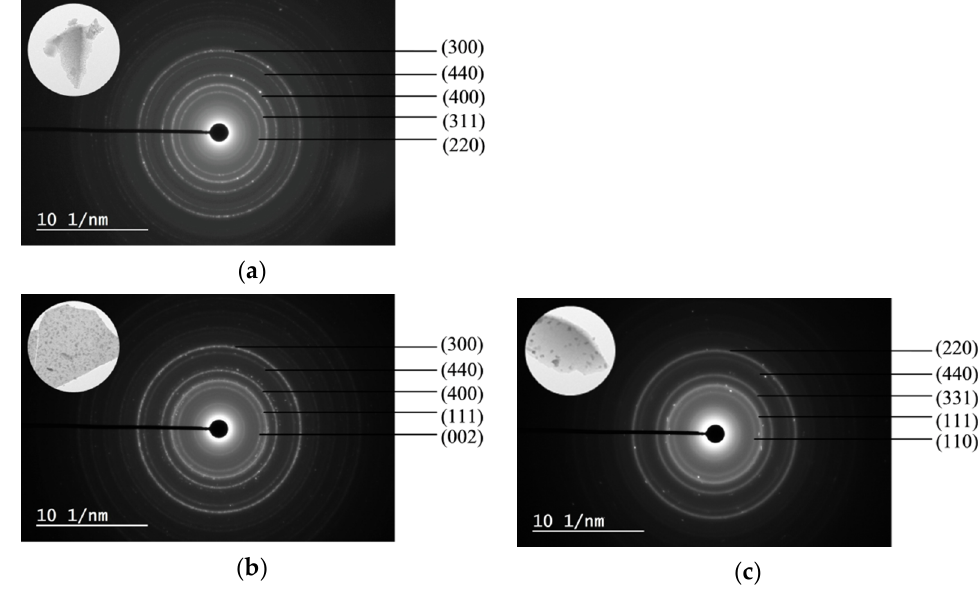
Figure 7. SAED patterns of the ( a ) 5Ni5CoAl ( b ) 5Ni5CuAl and ( c ) 5Co5CuAl catalyst samples.